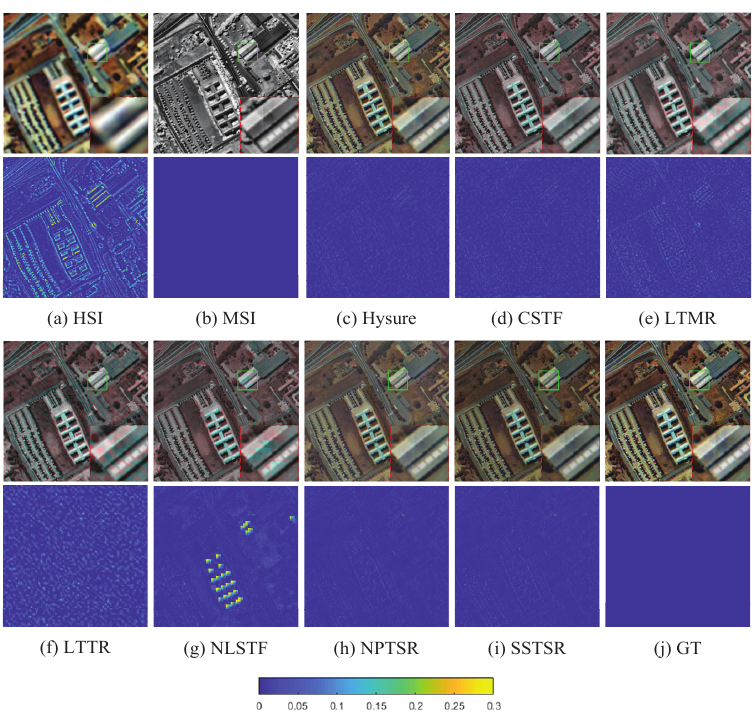
Figure 5. The first and third rows show the false color images (composited by bands 70, 35, 5) of the comparison methods on the University of Pavia data set. The second and fourth rows show the normalized residual images of the comparison methods at band-50.